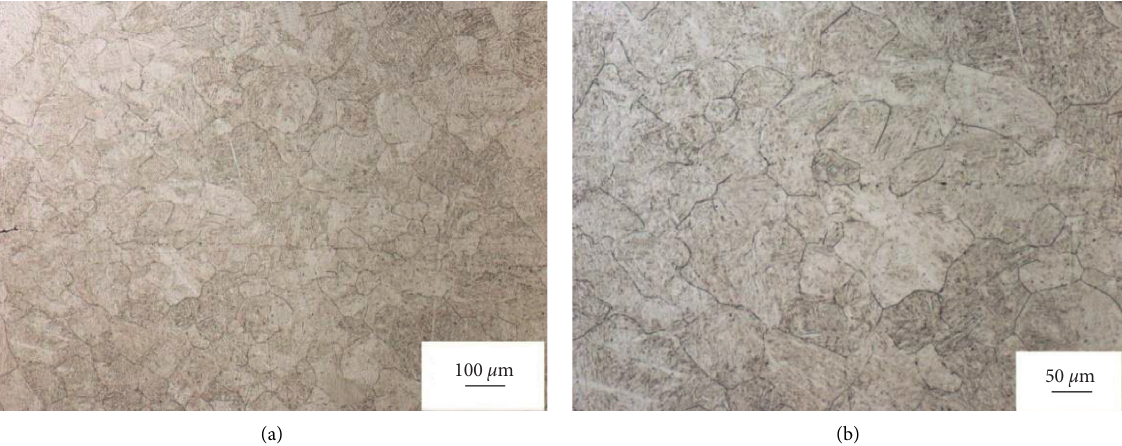
Figure 8: Microstructure of the crack healing zone at FR 2.2. (a) 100 times magnification. (b) 200 times magnification.